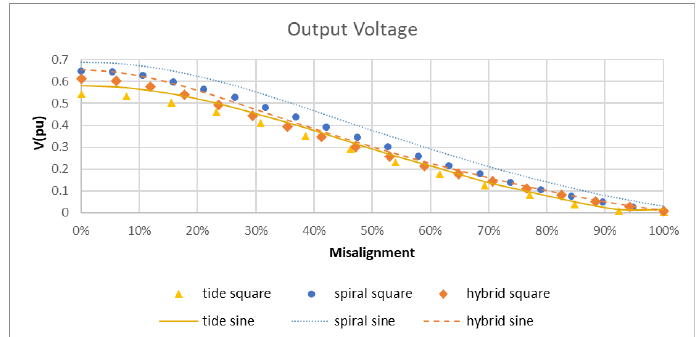
Figure 20 Figure 20. Measured output voltage for pure resistive load.